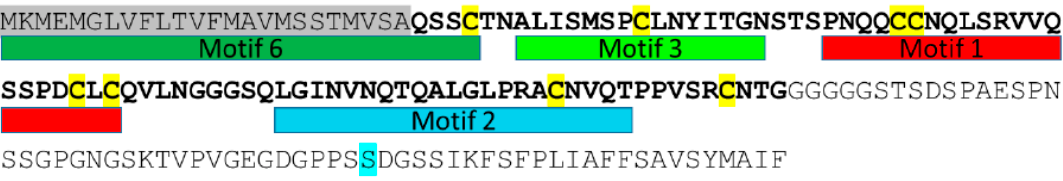
Figure 4. Sequence of LTPg5 protein, including the identified motifs. Signal peptide is shown in grey and the sequence corresponding to the nsLTP is in bold. Cysteine residues are marked yellow. Motifs are shown below the sequence. The GPI anchor is attached at amino acid 146 (S, marked blue).